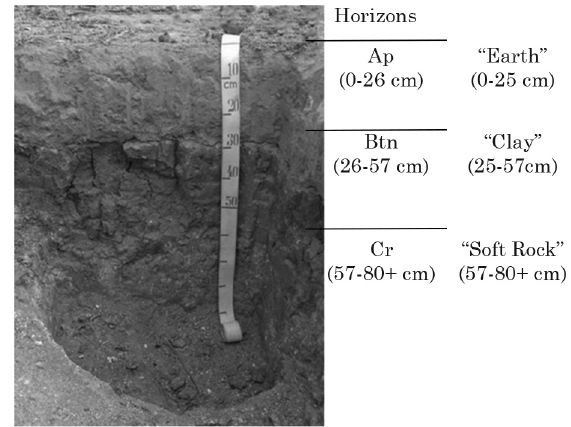
Figure 2. Planossolo Háplico eutrófico solódico textura média/argilosa (Typic Albaqualf) found in the surroundings of a clay pit used by local people to mine pottery clay (“barro de loiça”) in the region agreste of Pernambuco, Northeastern Brazil. Layers identified by local potters are indicated beside the